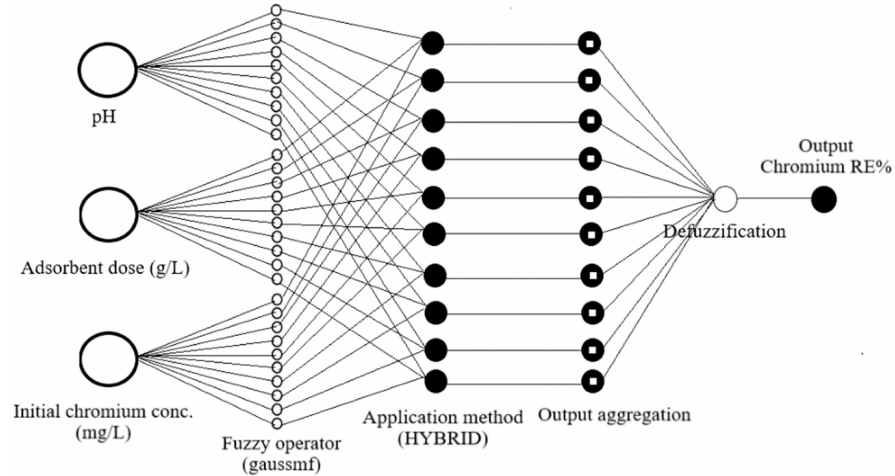
Figure 2. Adaptive neuro–fuzzy interference system